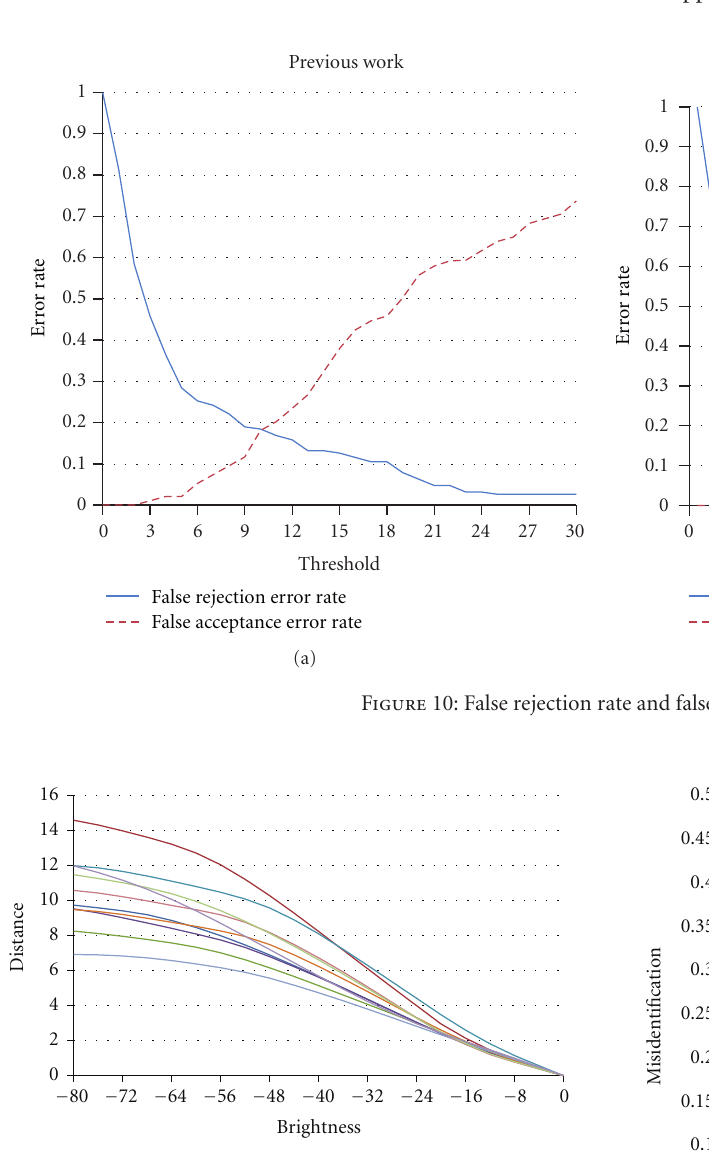
Figure 11: Euclidean distance of image feature as brightness changes. Table 3: Misidentification at di ff erent brightness levels. Only angle System I System II